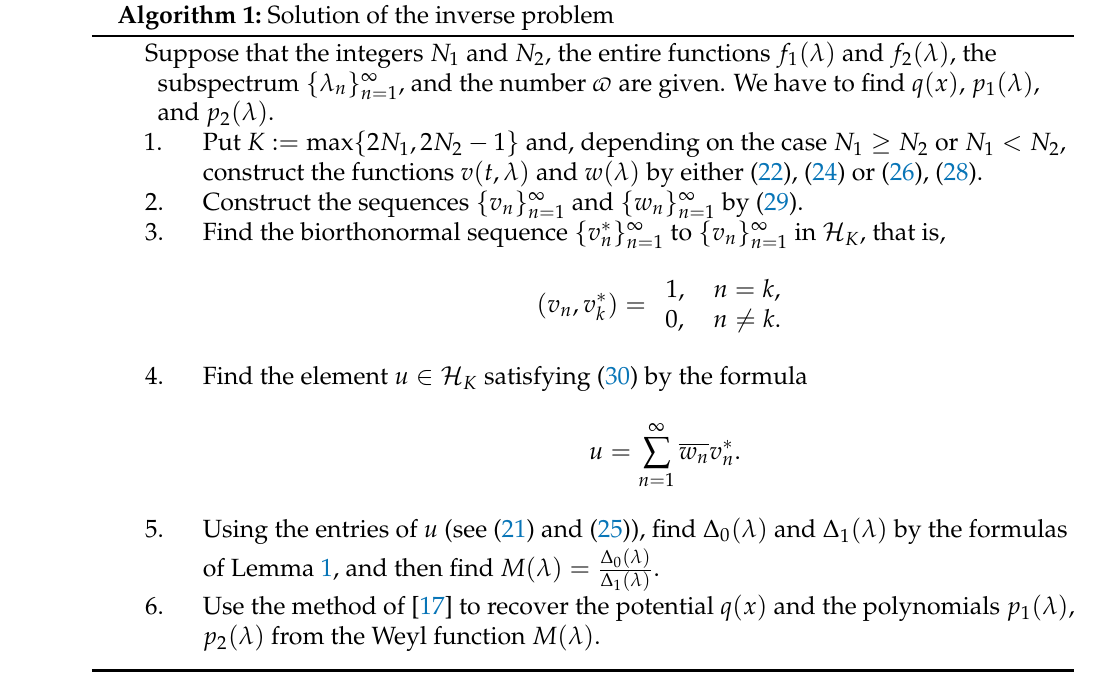
Algorithm 1: Solution of the inverse